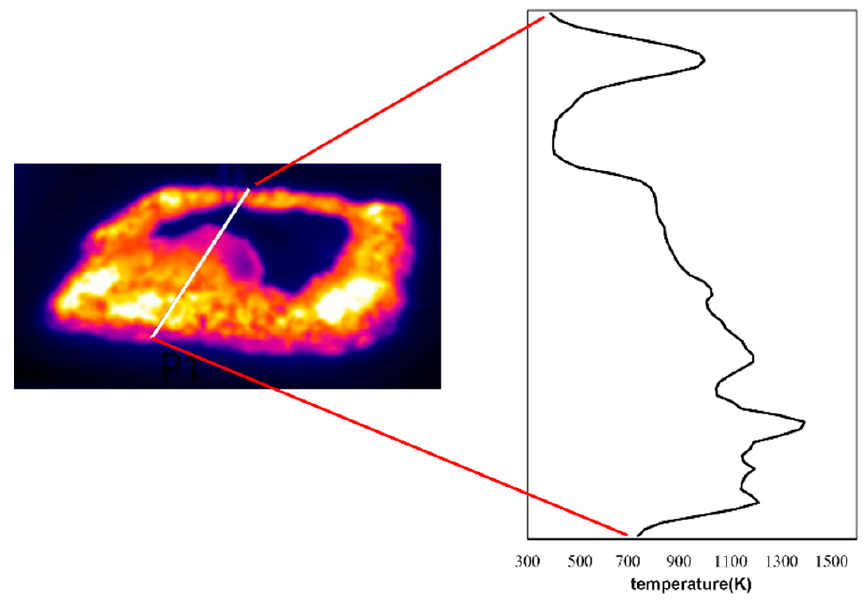
Figure 12. Temperature distribution of magnesium combustion over time ( a – e ).